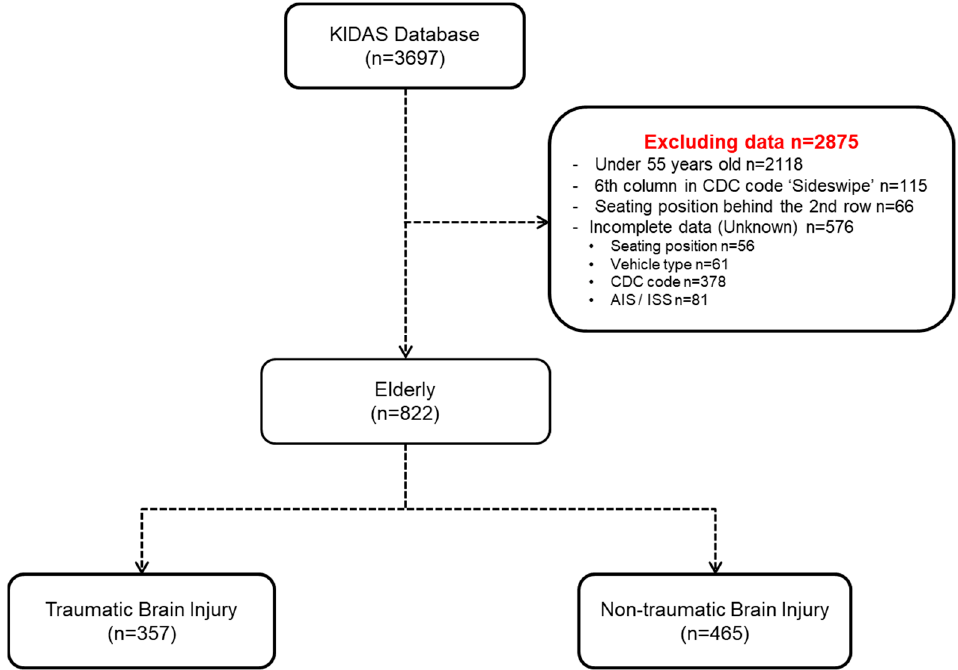
Figure 1. Flowchart of classifying the data. KIDAS: Korean In-Depth Accident Study, CDC: Collision Deformation Classification, AIS: Abbreviated Injury Scale, ISS: Injury Severity Score.